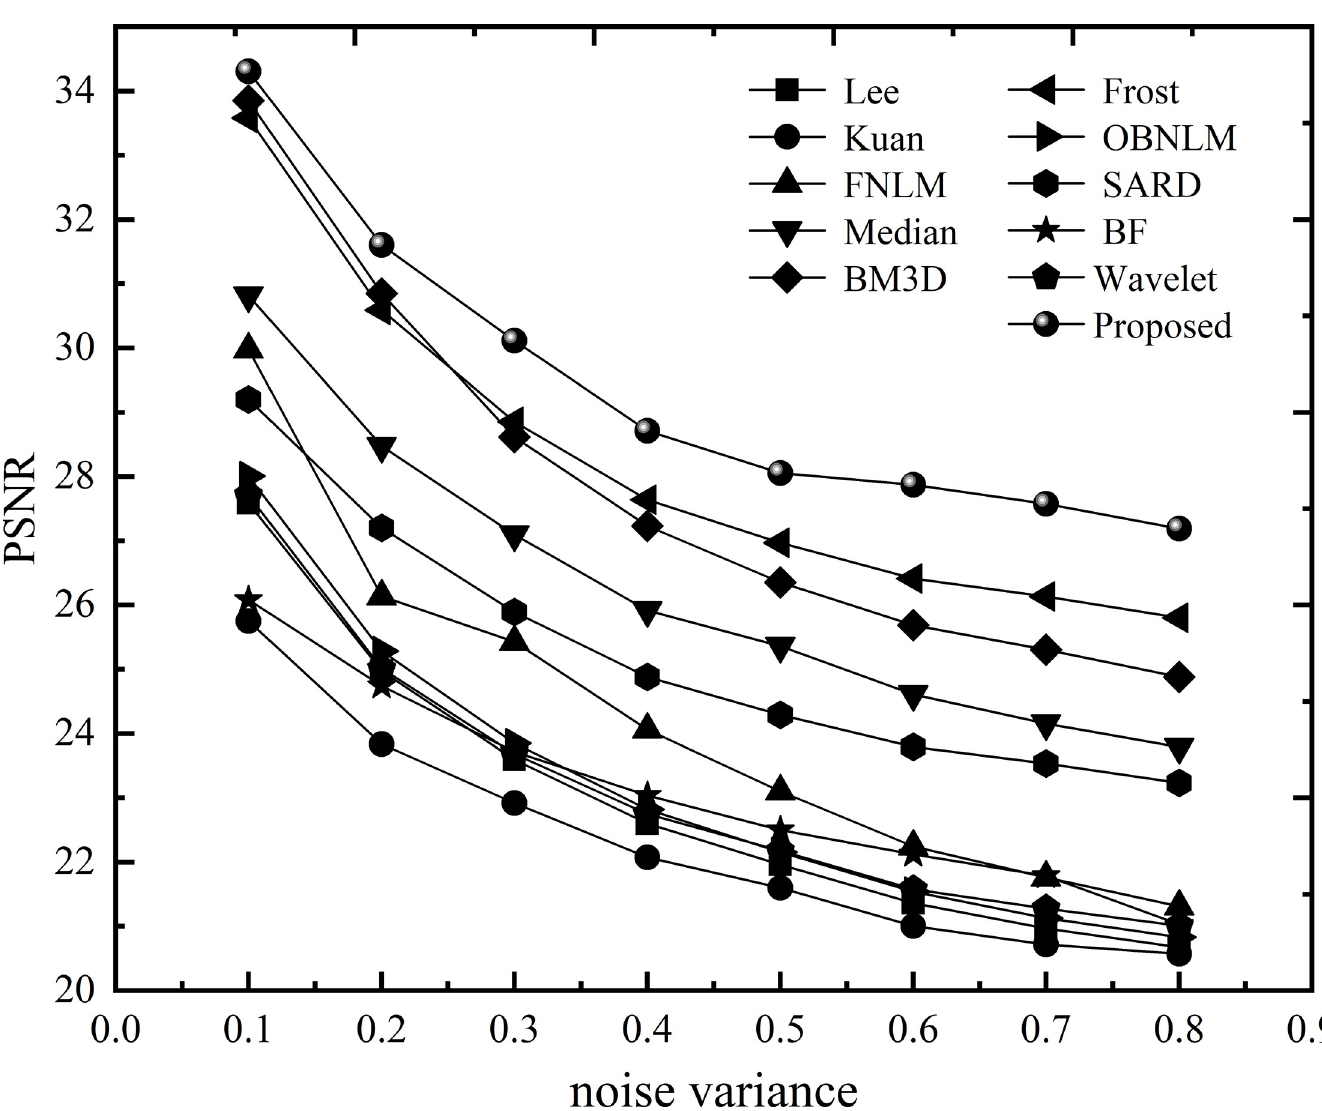
Fig 6. PSNR value of each algorithm under different